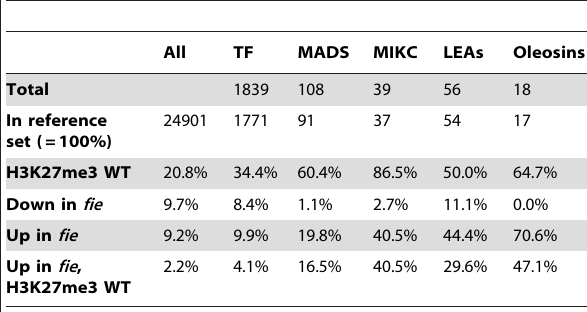
Table 2. Overrepresentation of in wild-type H3K27me3 marked and in fie up-regulated genes in specific gene classes.